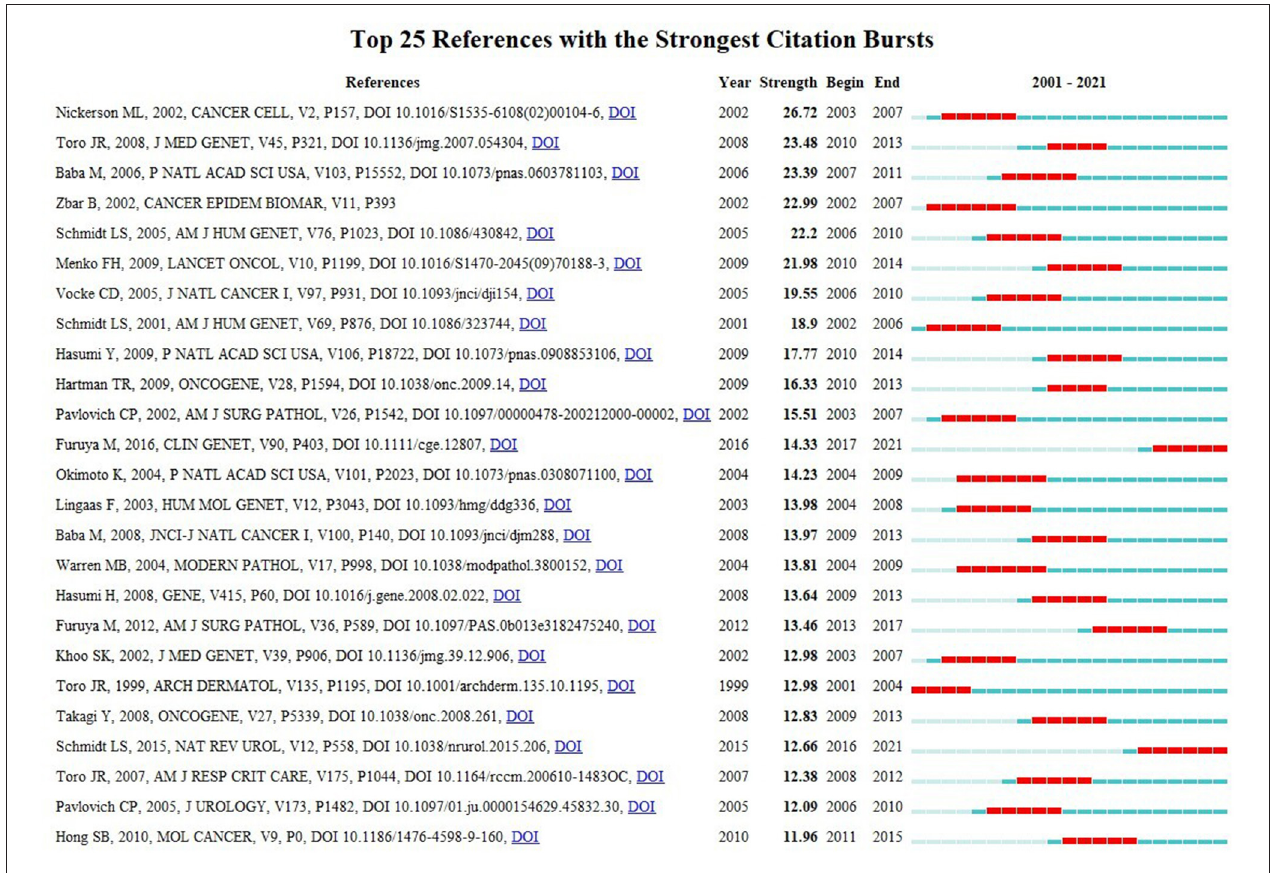
FIGURE 4 | Twenty five references with the strongest citation bursts related to BHD. Notes: This visualization shows which references have the strongest citation bursts and which periods the strongest bursts took place. For example, from the list, we can tell that Nickerson et al. ( 9) has the strongest bursts among articles published from 2003 to